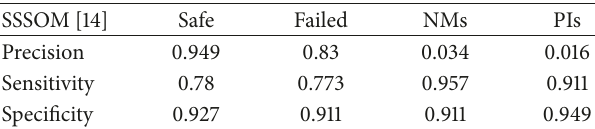
Table 2: Barycenter based SSSOM performances: precision, sensi- tivity, and specificity for each class.